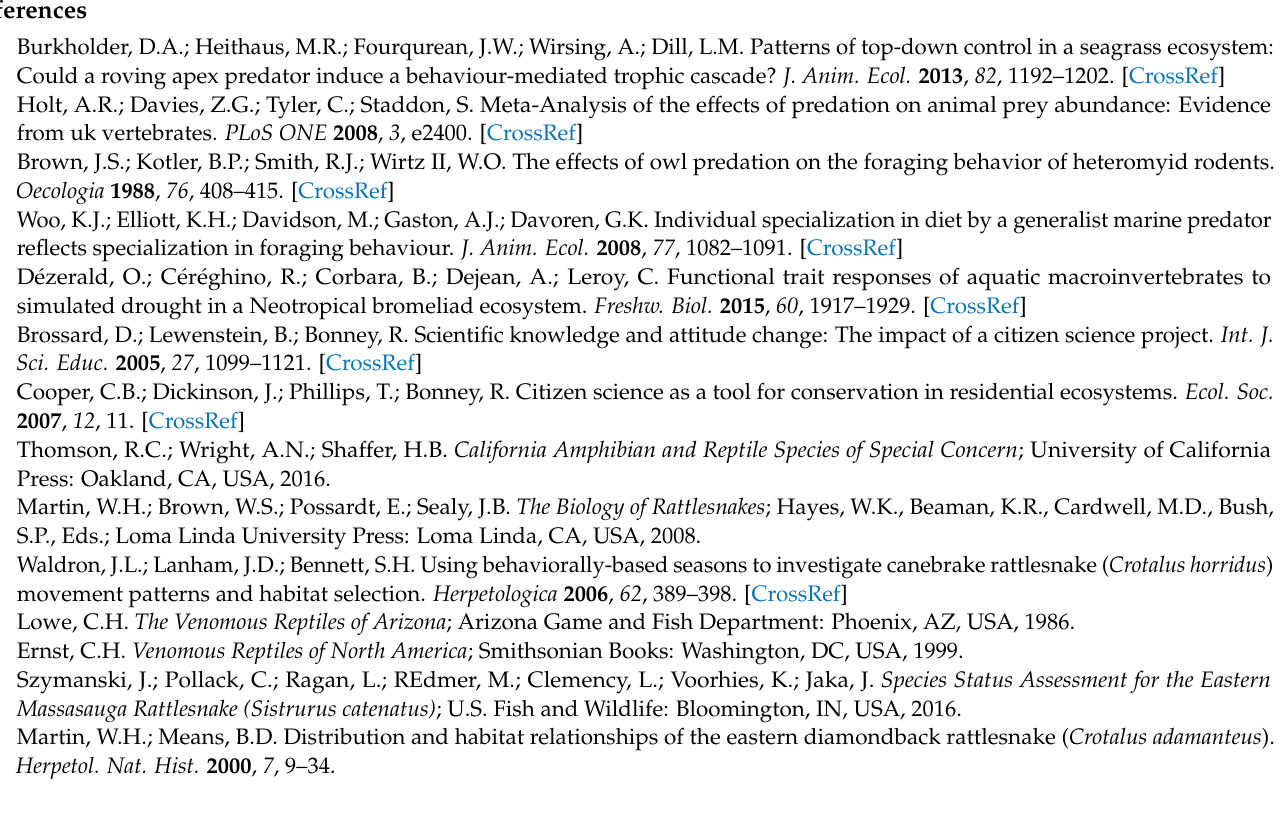
Table S1: Final Data